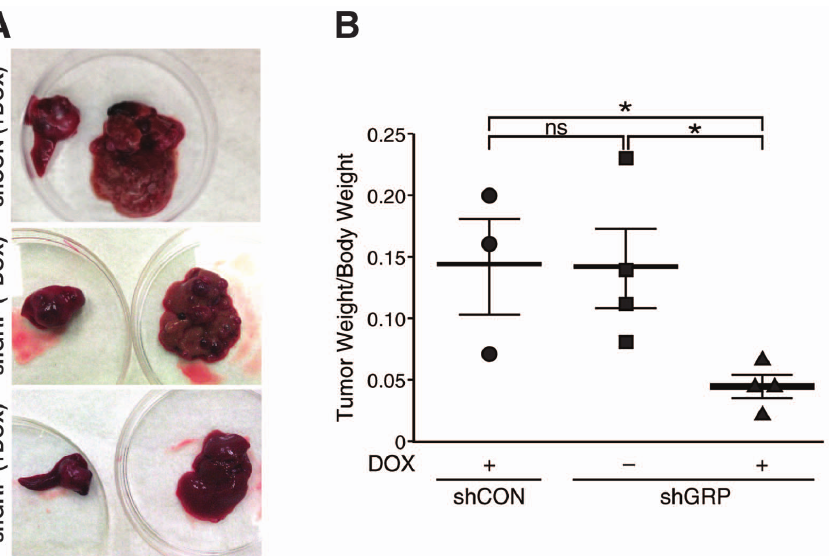
Figure 5. Targeted silencing of GRP inhibited liver metastasis. (A) Large gross tumors were observed in the spleen and liver of mice injected with BE (2)-C/Tet/shCON and subjected to drinking water with doxycycline (2 mg/mL) and 3% sucrose [shCON ( + DOX)] or injected with BE (2)-C/Tet/ shGRP and subjected to drinking water with 3% sucrose alone [shGRP (-DOX)], whereas, a near complete inhibition of hepatic metastatic lesions was observed in mice subjected to drinking water with doxycycline (2 mg/mL) and 3% sucrose [shGRP ( + DOX)]. (B) Liver tumor weights of mice injected with BE (2)-C/Tet/shGRP and receiving doxycycline in drinking water significantly decreased in comparison to control groups (mean 6 SEM; *= p ,